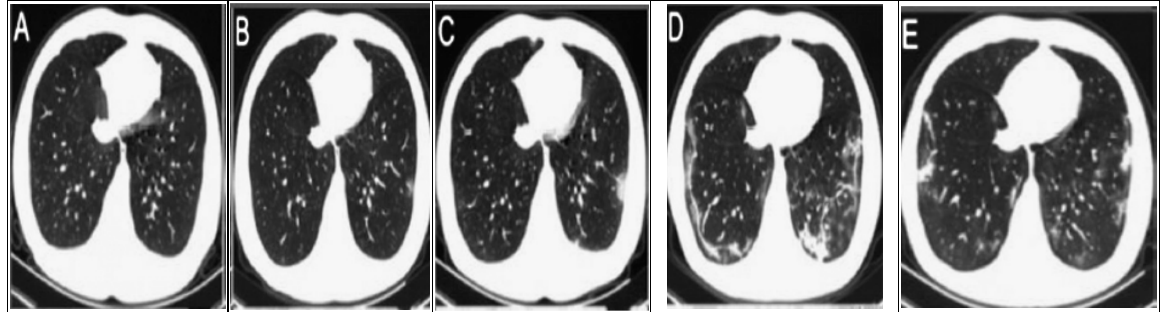
Figure 4. ( A – E ) subfigures show progression of a CT scan of a COVID-19 patient across days (2, 4, 5, 6, and 8, respectively). A pioneering effort in collecting public CT scans datasets was in [236]. The dataset consists of 125 chest CT scans. It includes images of several classes (COVID-19, SRAS, MERS, and ARDS). The dataset was collected from several websites and publications, which may affect the image quality and even the performance of the ML model [237].